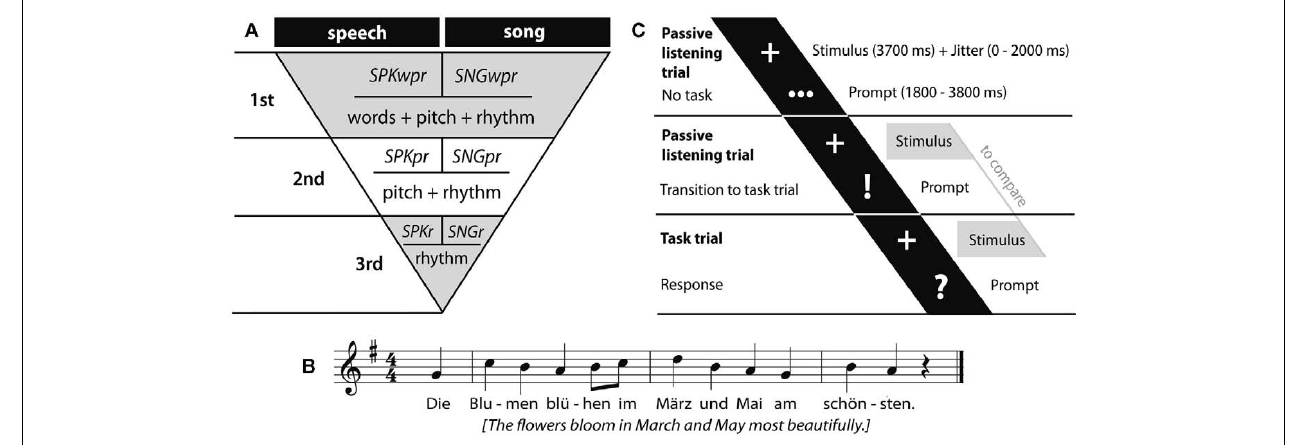
(containing pitch pattern and rhythm), third level: SPKr and SNGr (containing rhythm). (B) Stimulus example. (C) Timeline of passive listening trial and task